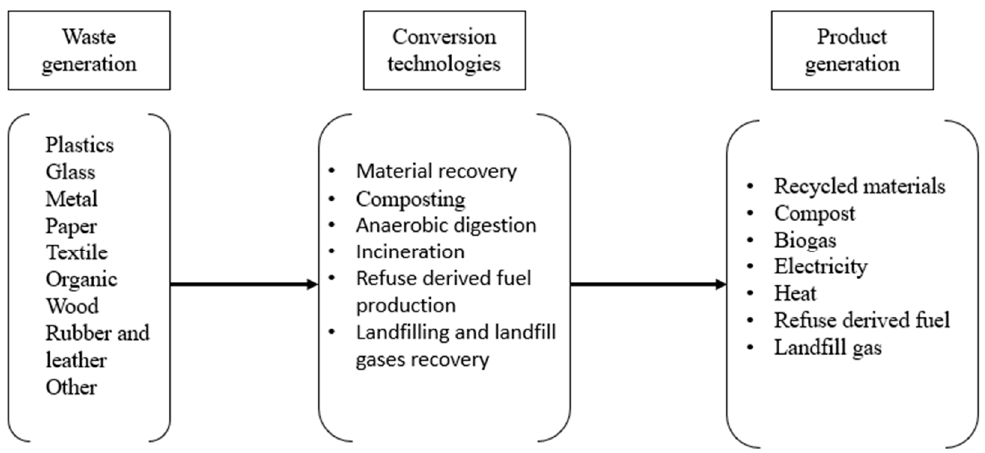
Figure 1. Possible waste generation relationship between their conversion technologies, reproduced with permission from [20]. Copyright Elsevier, 2017.